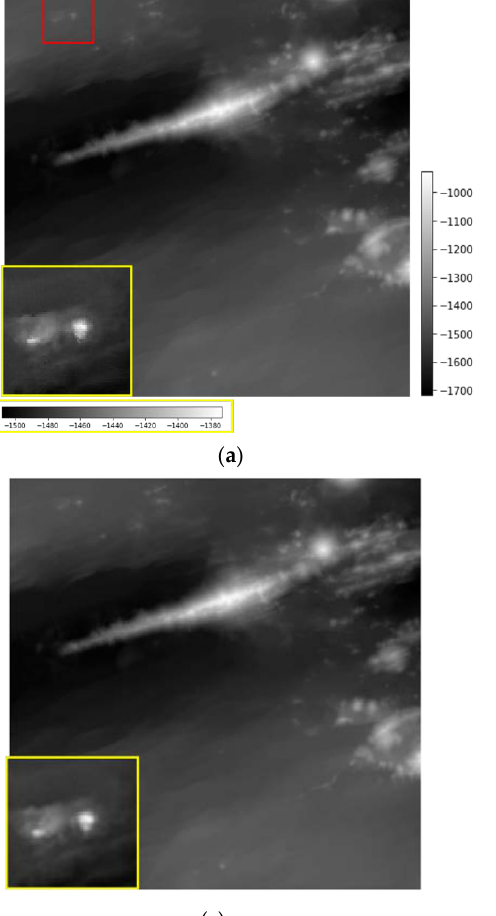
Figure 4. High-resolution image patch of high-frequency component trained with the area 0_0.